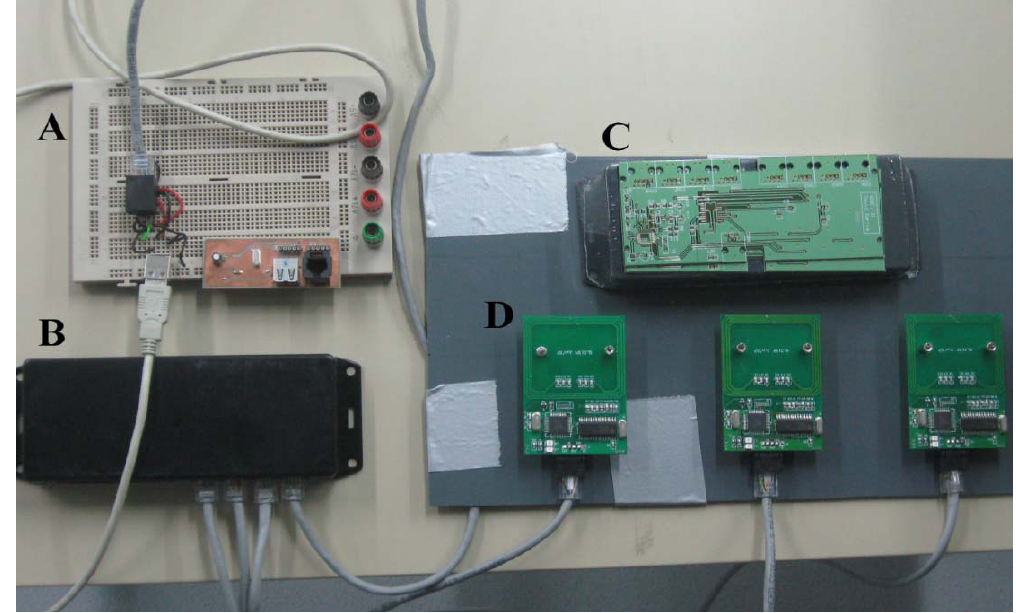
Figure 2. The components of the RFID system used to individually track the behaviour of Nephrops within a laboratory microcosm tank. The different elements are A , the USB to RFID controller interface; B , the RFID controller; C , the RFID controller electronic board in detail; and D , the